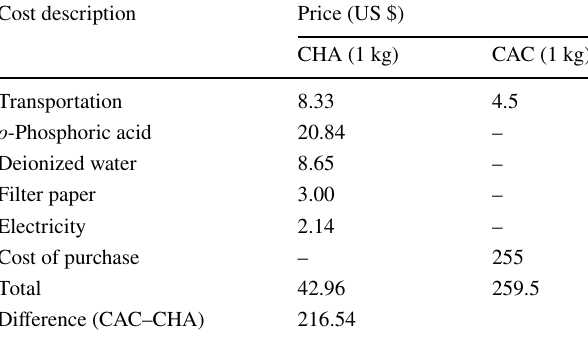
Table 9 Price d ifference between CHA and